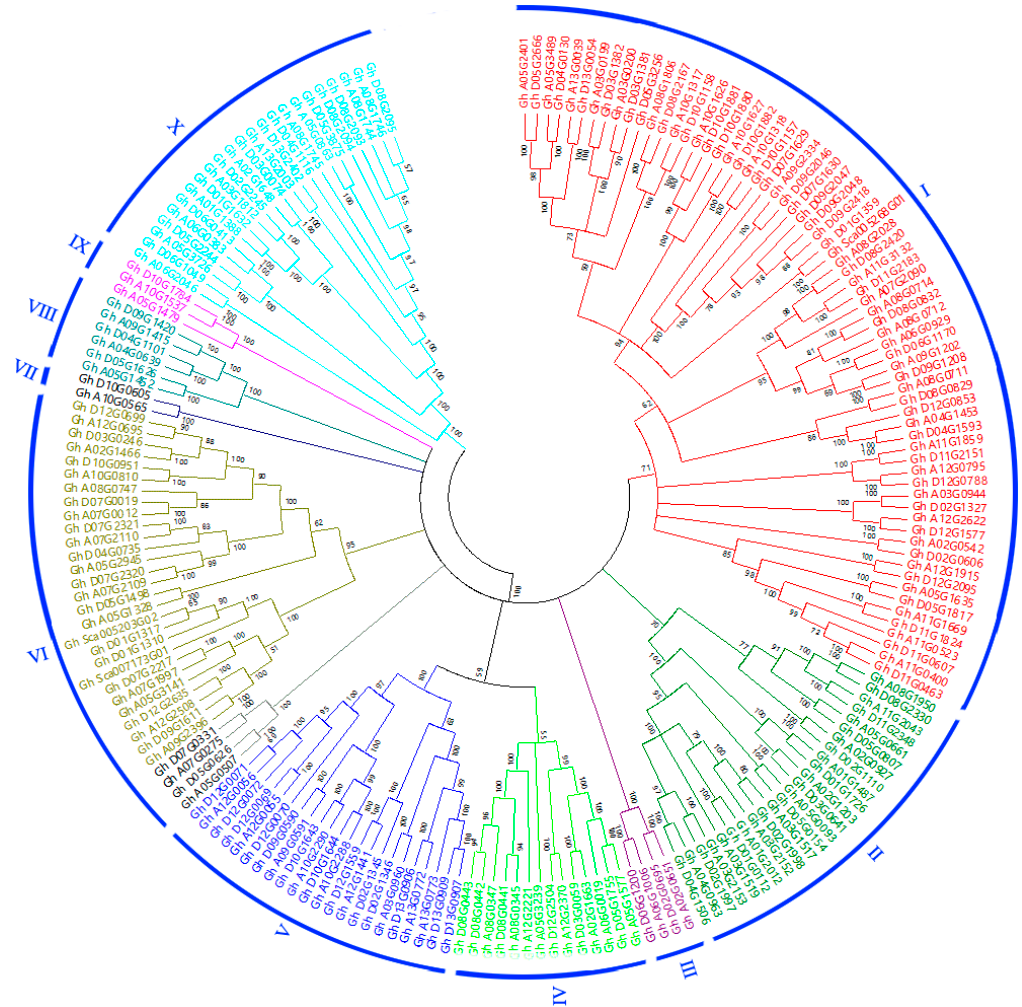
Figure 1. Phylogenetic relationship of the 198 identified upland cotton POD genes. Unrooted tree constructed using MEGA5.02 by the Neighbor-Joining (NJ) method. Bootstrap values (above 50%) from 1000 replicates are indicated at each node. The tree shows 10 major phylogenetic subfamilies (subfamilies I to X).